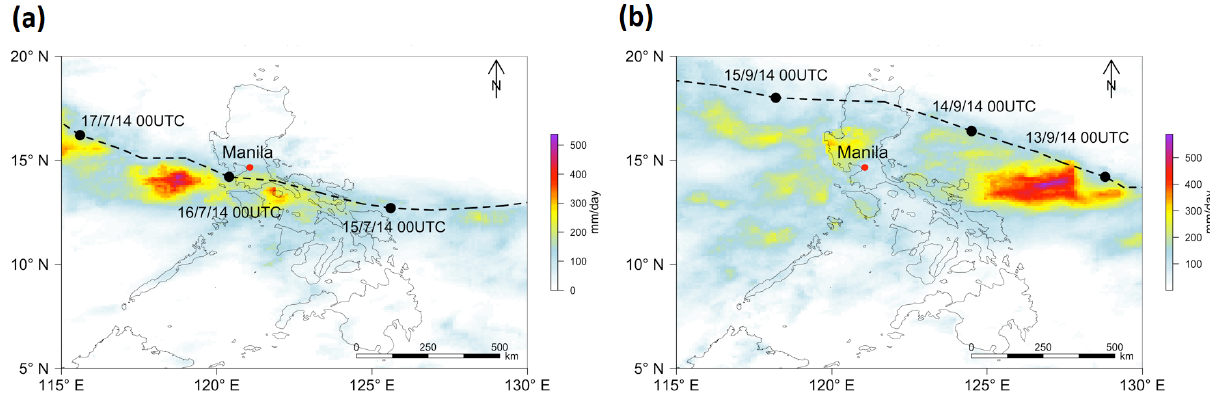
Figure 6. Accumulated precipitation from IMERG satellite data and TC tracks from IBTrACS for (a) Rammasun with precipitation accumu- lation for 14–17 July 2014 and (b) Kalmaegi with accumulated precipitation for 12–15 September 2014. Made with base layers from Natural Earth. Please note that the date format in this figure is day/month/year.